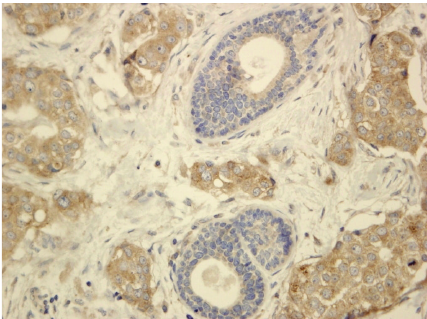
Figure 1: Microphotography of breast cancer tumour with strongly immunohistochemical staining for VEGF (brown staining) (HE; × 40).